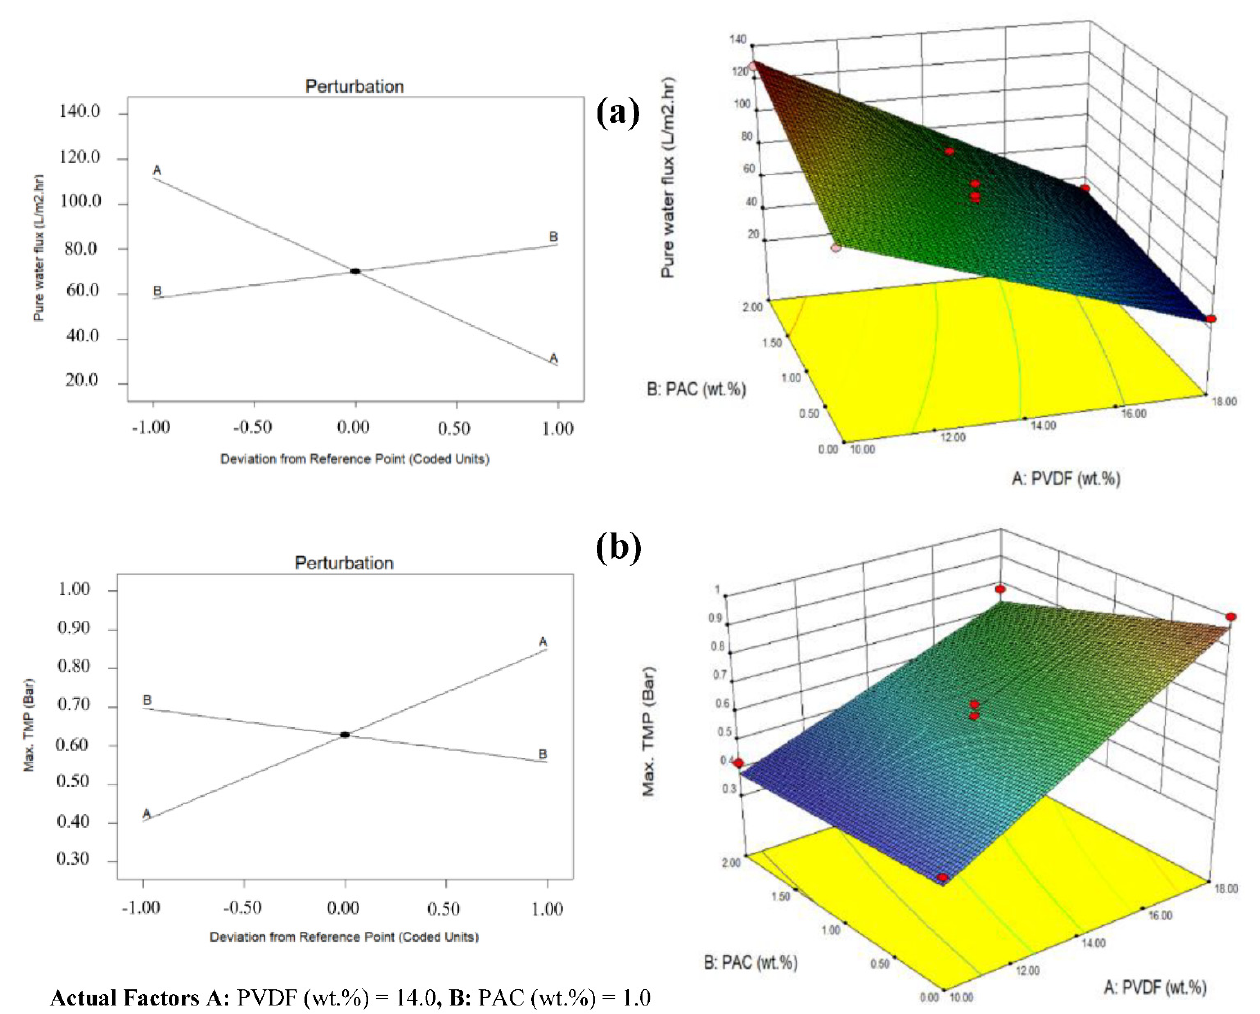
Figure 7. Perturbation plots ( left ) and 3D response surface ( right ) of PVDF-PAC fabricated membrane for ( a ) pure water flux and ( b ) max. TMP.